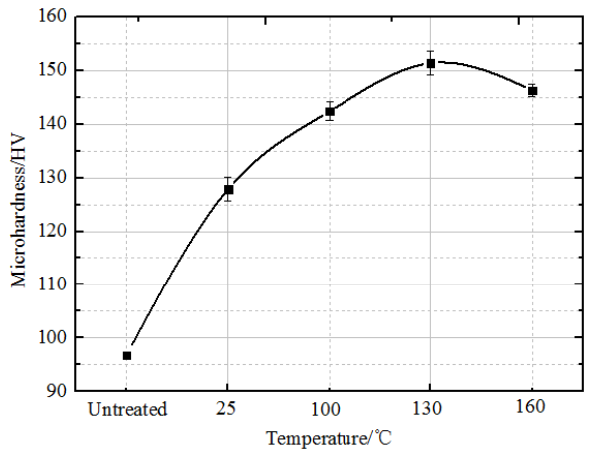
Figure 6. Microhardness distribution at different temperatures.